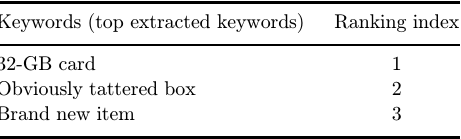
Table 6. Extracted keywords from the top critical reviews for Cannon cameras. Keywords (top extracted keywords)